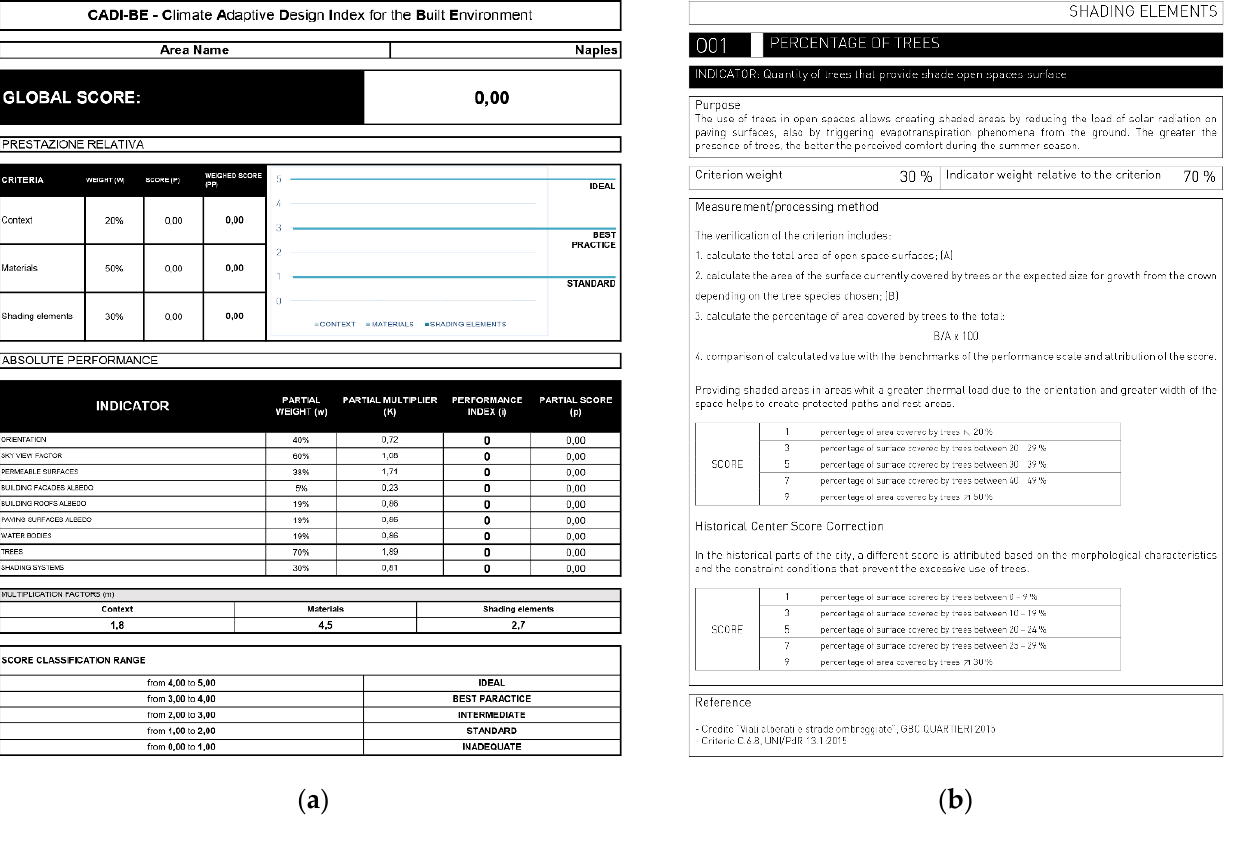
Figure 14. CADI-BE evaluation system sheets: ( a ) compilation sheet; ( b ) indicator sample sheet.